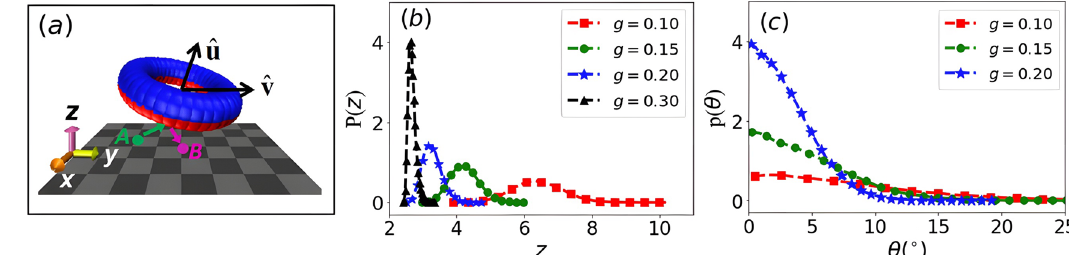
Fig. 1 Schematics of a Janus torus. a Janus torus with catalytic (red) and noncatalytic (blue) faces. The catalytic reaction, A → B , occurs on the catalytic surface and converts fuel A particles to product B particles. The symmetry axis of the torus is indicated by the unit vector ^ u pointing from the catalytic to noncatalytic face of the torus. The vector ^ v is the center of mass (c.o.m.) velocity. b The probability P ( z ) of the torus c.o.m.-wall distance for a backward- moving torus with its catalytic surface (red) facing the wall and c the probability distribution p ( θ ) vs the tilt angle θ of a backward-moving torus for various values of gravitational strength parameter g